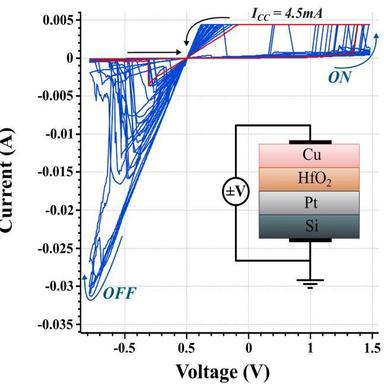
I-V characteristic of a bipolar Cu/HfO2/Pt memristor. During the positive voltage sweep, a compliance current of 4.5 mA is imposed. The first hysteresis cycle is shown in red, while the other 35 cycles are shown in blue. The arrows indicate the voltage sweep direction and mark the switching to the high resistance state (HRS) or OFF state and to the low resistance state (LRS) or ON state of the device. The inset shows a sketch of the measured memristor. The HfO2 film was deposited by Pulsed Laser Deposition